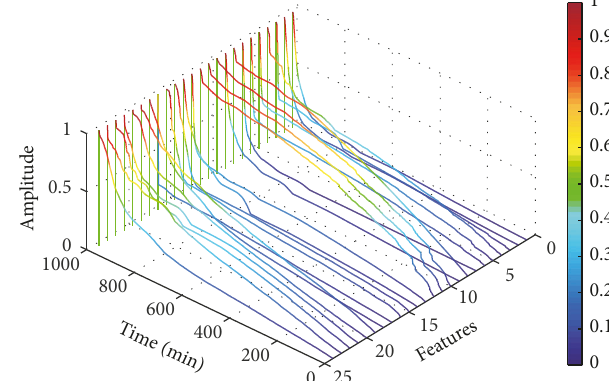
Figure 10: Waterfall of original features.